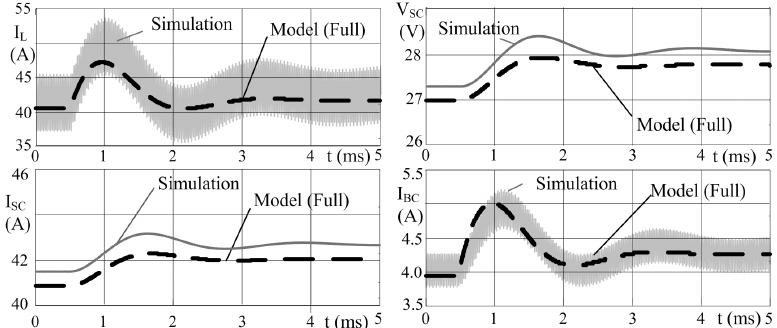
Figure 13. Simulation waveforms (gray) and averaged value of model based on the parameters of real components (black), for filter current ( I L ), load output current ( I SC ), load voltage ( V SC ) and input current ( I BC ).